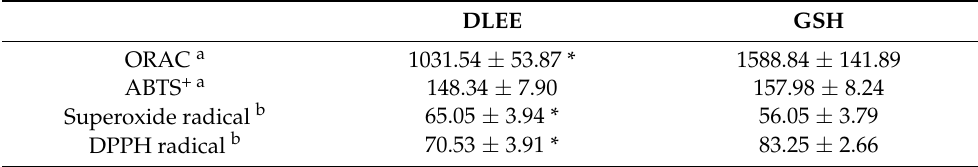
Table 1. The antioxidant activity of DLEE in comparison with GSH.